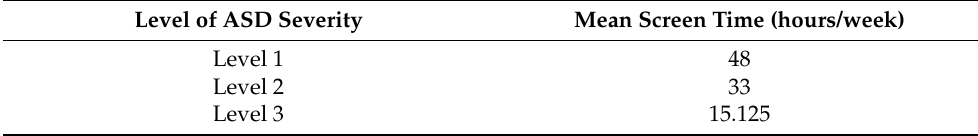
Table 4. Results Showing the Mean Screen Time with Different Levels of ASD